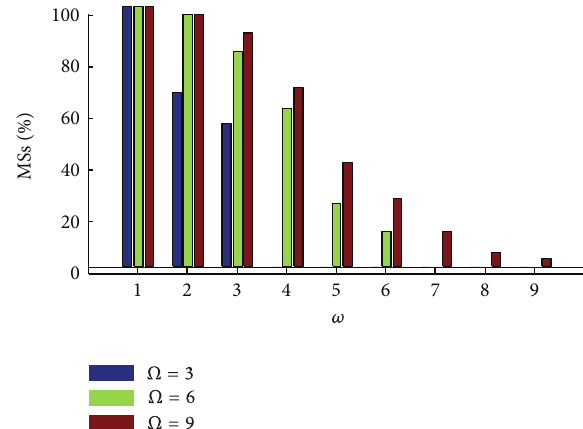
Figure 3: Penetration rate of user centric served